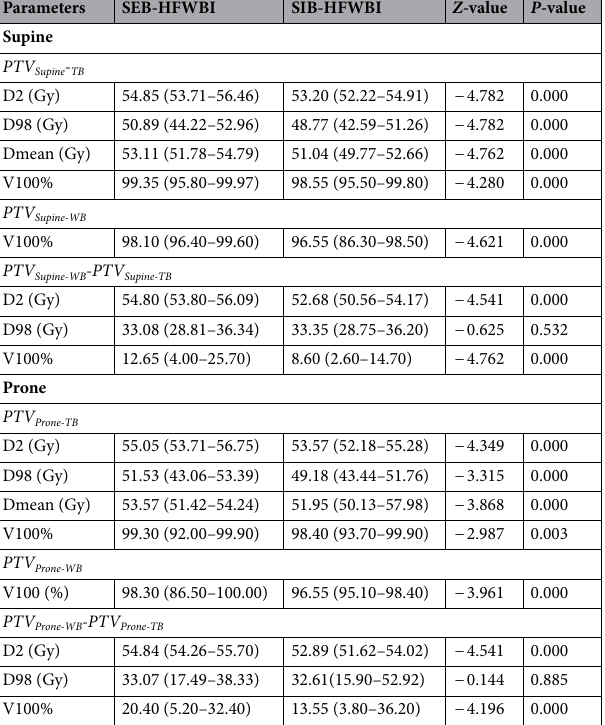
Table 2. Dosimetric evaluation of the targets for the SEB-HFWBI and SIB-HFWBI plans inthe same position (median). TB tumor bed, PTV TB planning target volume for the TB, WB whole breast, PTV WB planning target volume for the WB, PTV WB -PTV TB the target volume obtained by subtracting the PTV TB from the PTV WB , SIB simultaneous integrated boost, SEB sequential integrated boost, HFWBI hypofractionated whole-breast irradiation, D2 doses covering 2% of the PTV, D98 doses covering 98% of the PTV, Dmean mean dose, V100% the PTV coverage percent of the 100% prescribed dose line including PTV TB , PTV WB , PTV WB -PTV TB in the treatment plan under supine and prone positions.